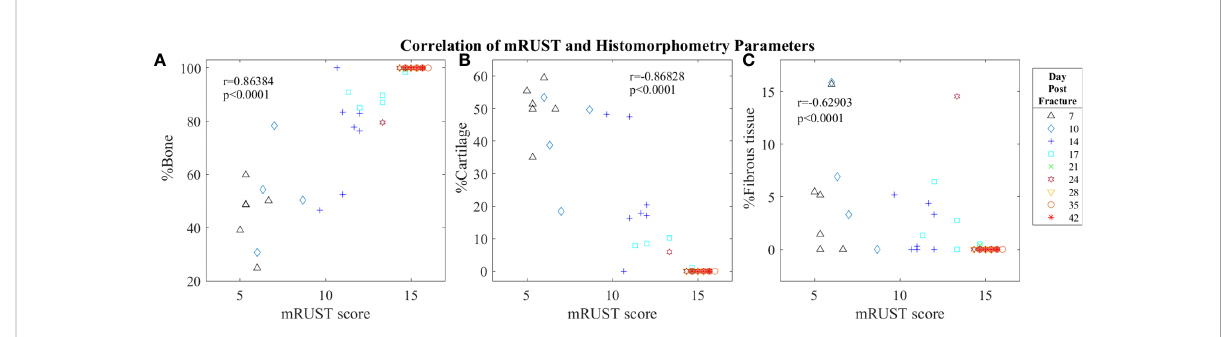
FIGURE 6 Symbol and color plot of mRUST correlations with (A) %Bone, (B) %Cartilage, and (C) %Fibrous tissue. Each point represents an individual